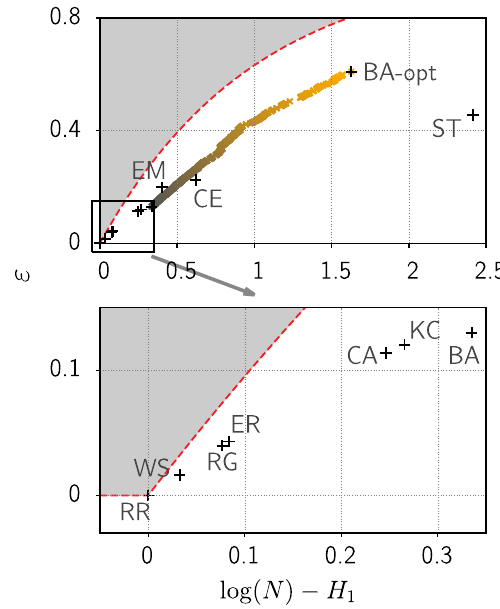
FIG. 3. Quantumness and degree entropy. The value of " against H 1 [Eq. (10)] for the nine different networks considered in Fig. 2, as well as the random regular (RR) network (a network with the same degree for each node—in this case, we consider a regular graph with each node of degree six) and star (ST) networks (black +). We also plot " and H 1 for the network obtained in several iteration steps, each randomly varying an internode weight of the BA network, for an increasing number of iteration steps (bottom to top, grey to orange x). The quantum- ness " increases and the entropy H 1 decreases with step number. The red dashed line represents the upper bound of Eq. (11).